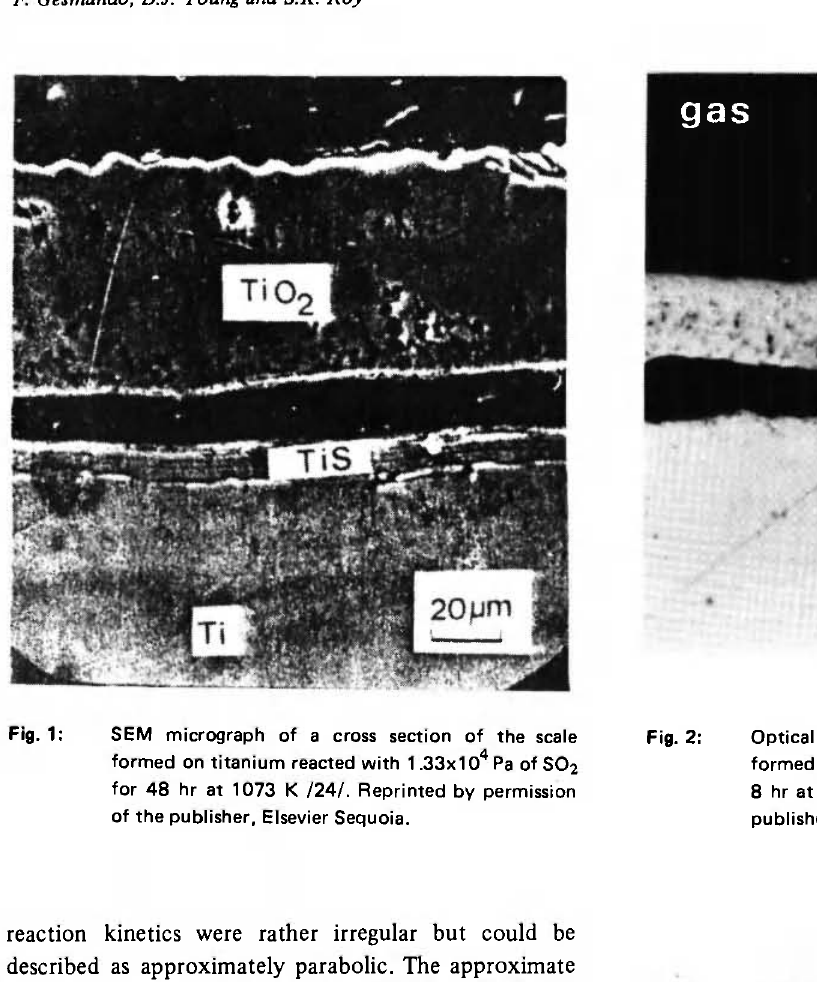
Fig. 1: SEM micrograph of a cross section of the scale formed on titanium reacted with 1.33x10 4 Pa of S0 2 for 48 hr at 1073 Κ /24/. Reprinted by permission of the publisher, Elsevier Sequoia.